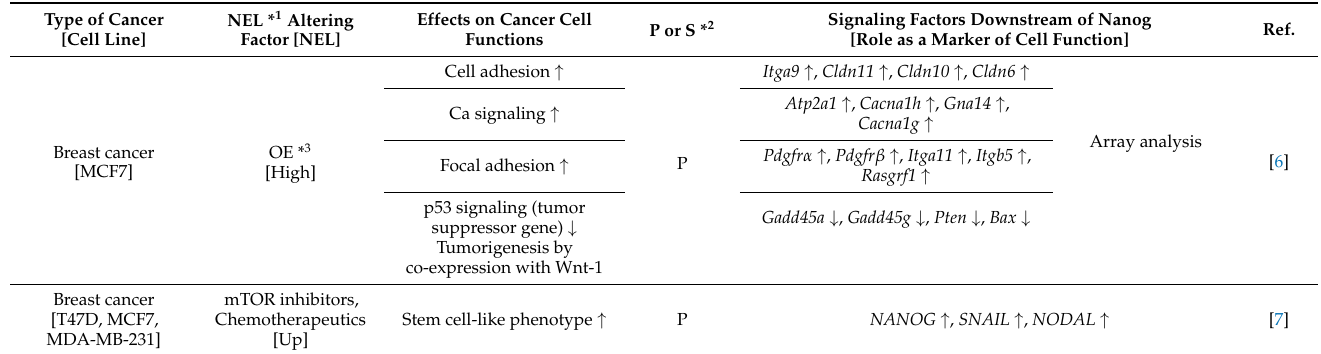
Table 1. Effects of the alteration of Nanog expression levels on cancer cell properties.